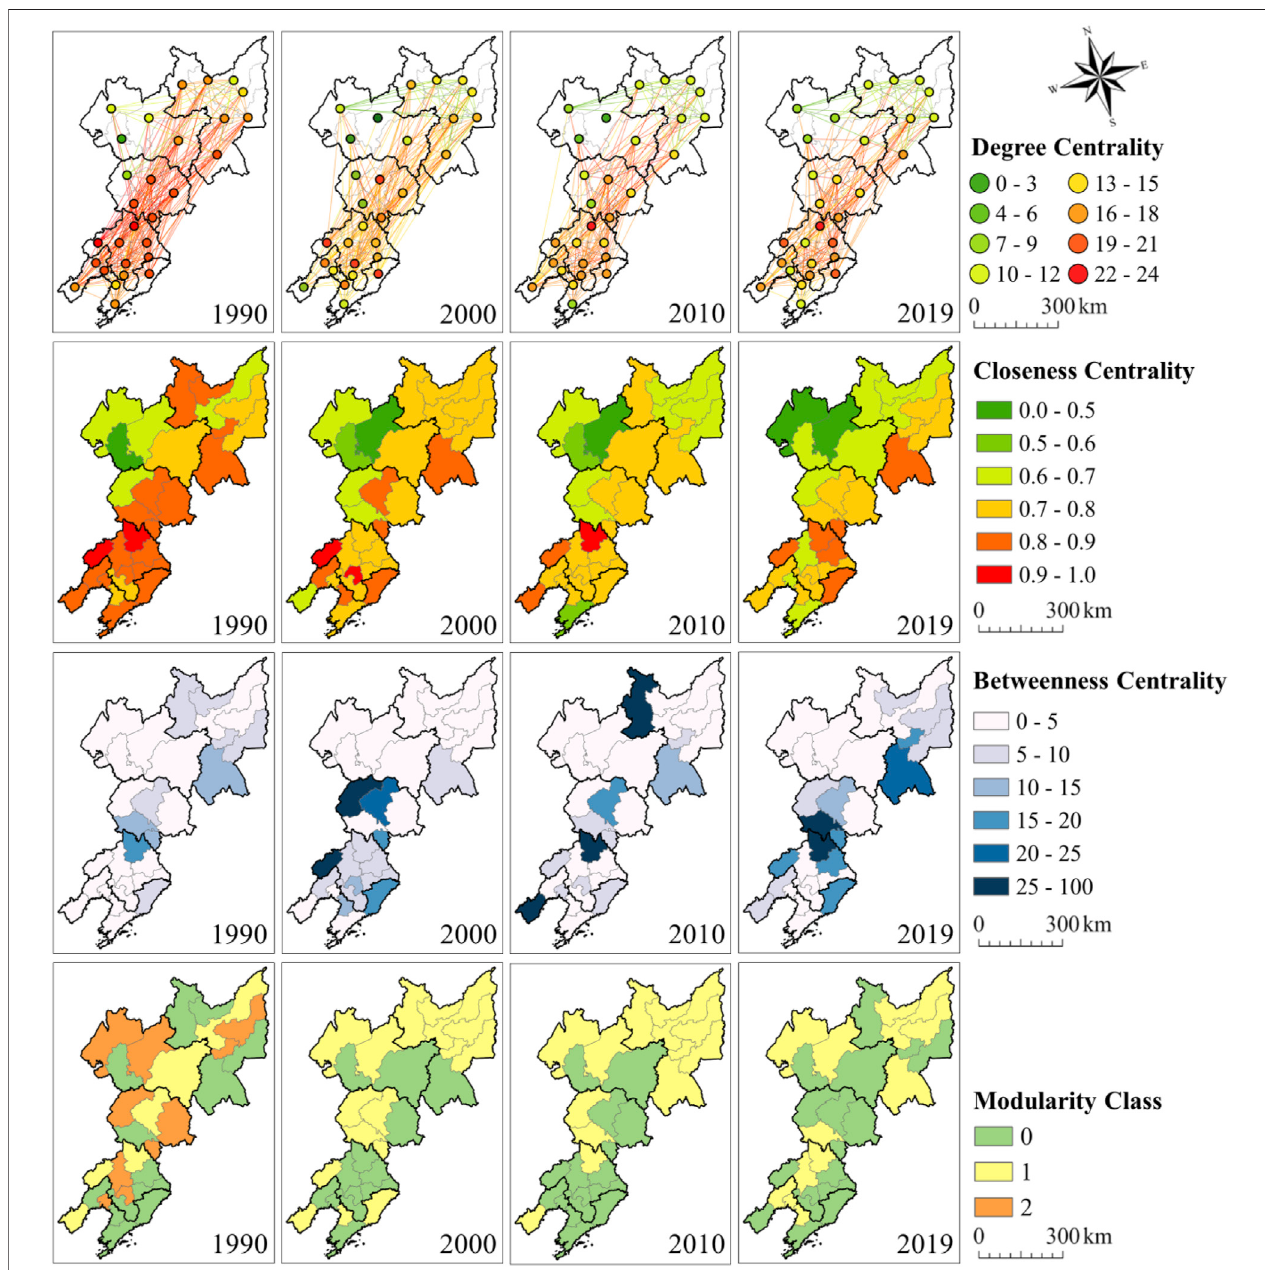
FIGURE 8 | Difference network structure